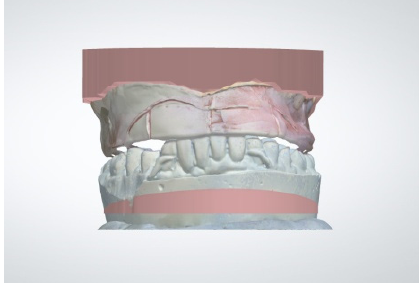
Figure 6. Digital maxillomandibular records.